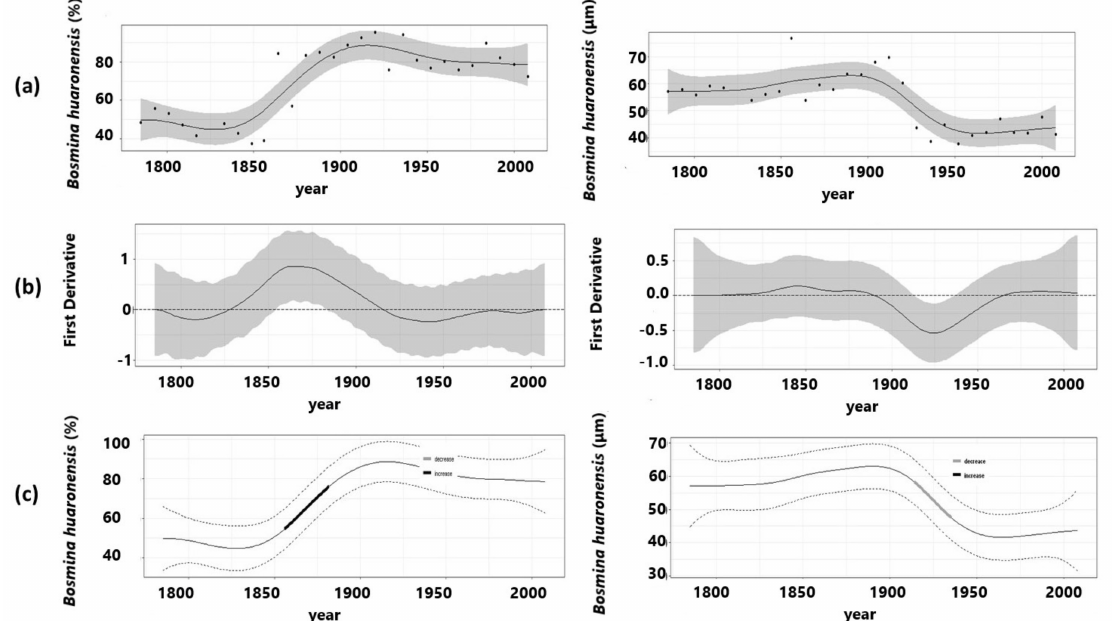
Figure 6. GAM fitted to the time series of Bosmina huaronensis abundance (chitinous remians) (left pannel) and mucrone size (right pannel)in the sedimentary archive of Lake Blanca Chica. ( a ) Observed values, GAM-based trend fitted and its simultaneous interval; ( b ) estimated first derivative of the GAM fitted trend and the 95% simultaneous interval; ( c ) period of